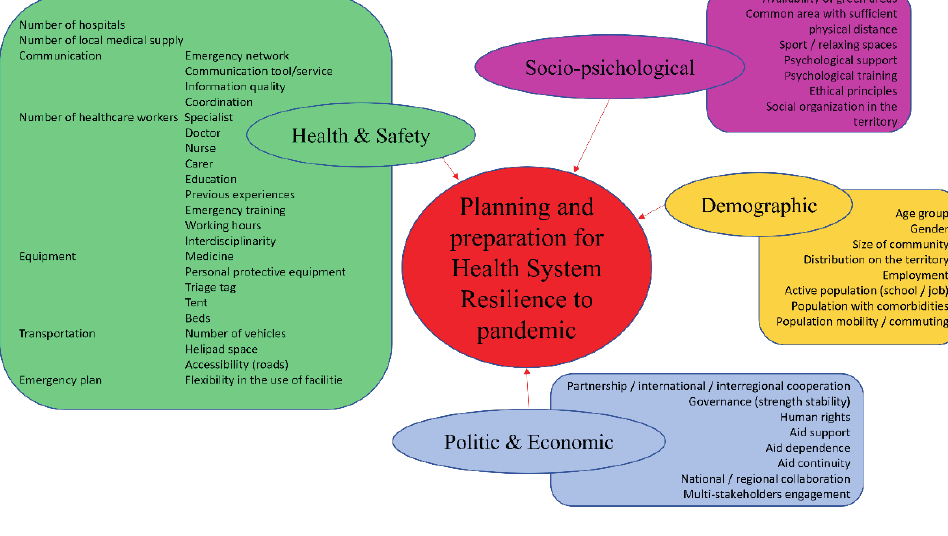
Fig. 1. Indicators (divided in macro areas) selected by the literature review for the Health System Resilience evaluation. The multi-criteria analysis methods emerging from the literature review are presented in Table